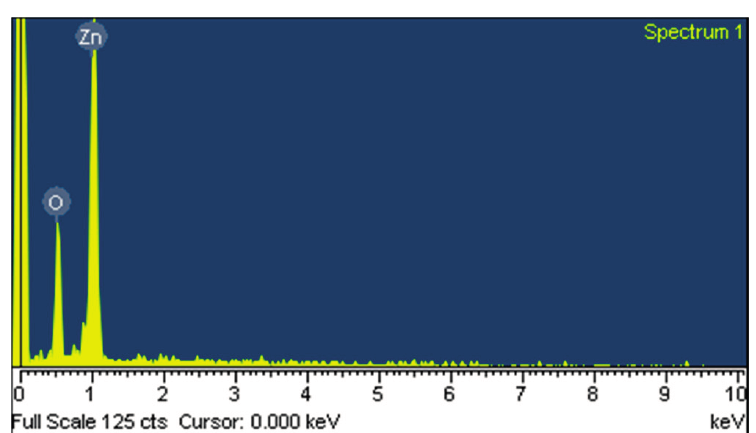
Figure 5. Elements of the zinc oxide film measured by